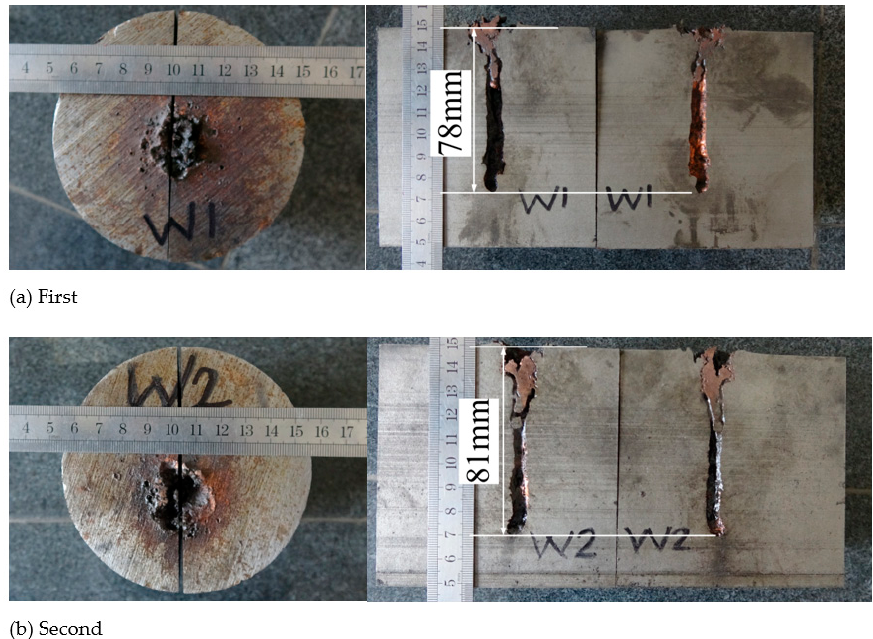
Figure 21. Diagram of the DOP experimental results.